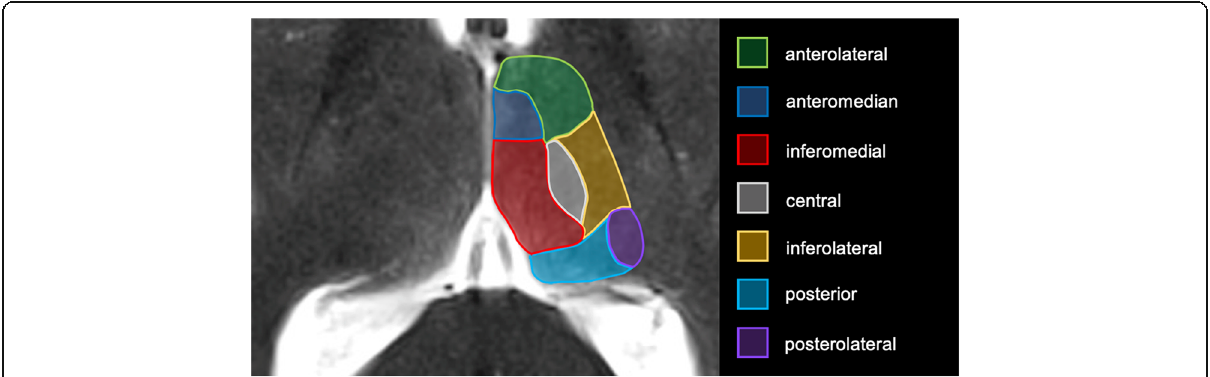
Fig. 2 The thalamic vascular territories as defined in this study projected on an axial T2-weighted MRI template. The map was created based on the literature [4, 7, 9, 12, 22] and includes the four traditional and three variant type vascular territories